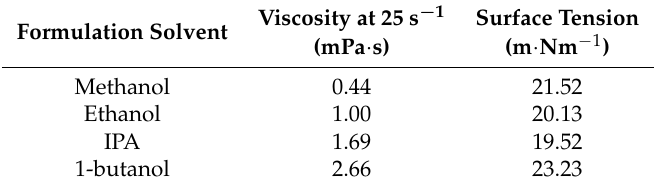
Table 3. Rheology measurements of MAI in alcohol formulations for slot-die